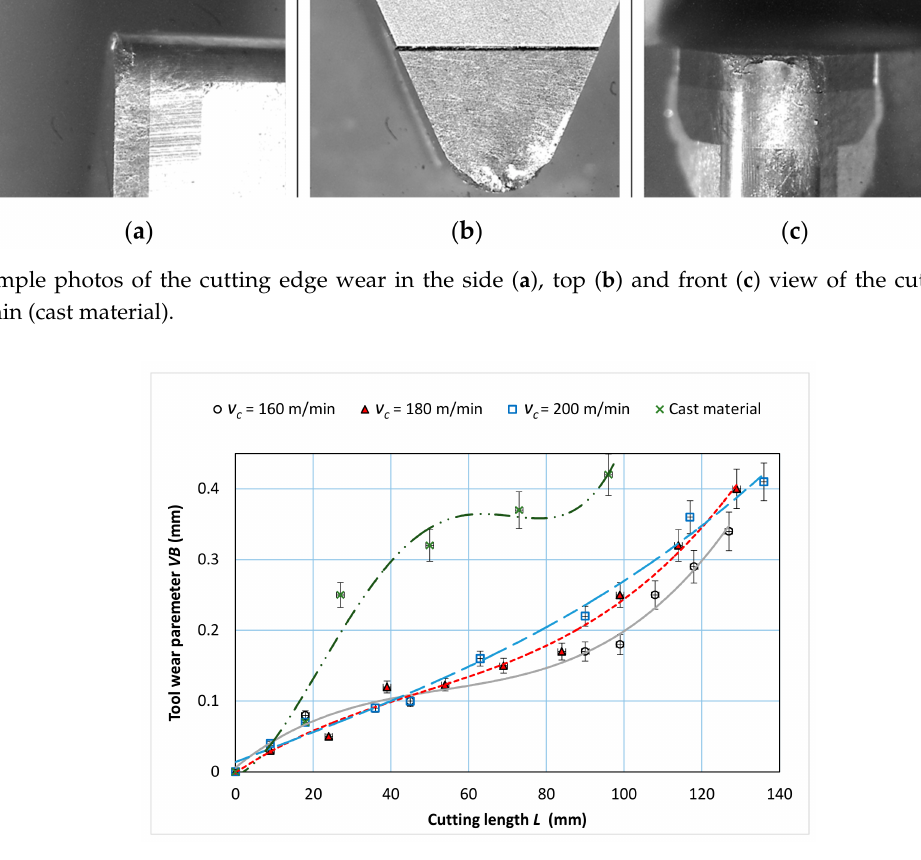
Figure 8. Tool wear characteristic as a function of the turning path L for the turning of sintered nickel-cobalt alloy with parameters: f = 0.048 mm/rev; a p = 0.5